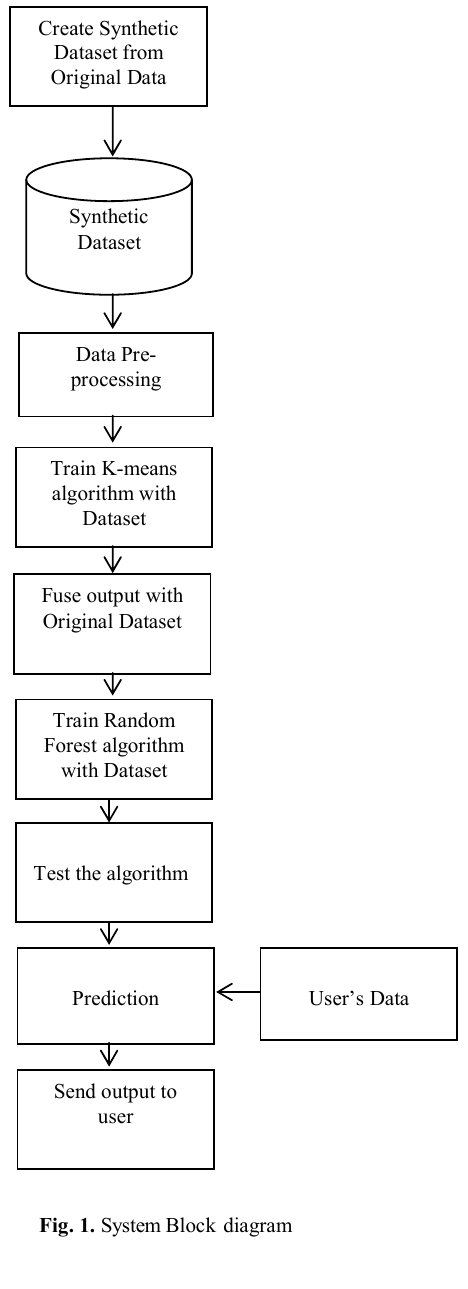
Fig. 1. System Block